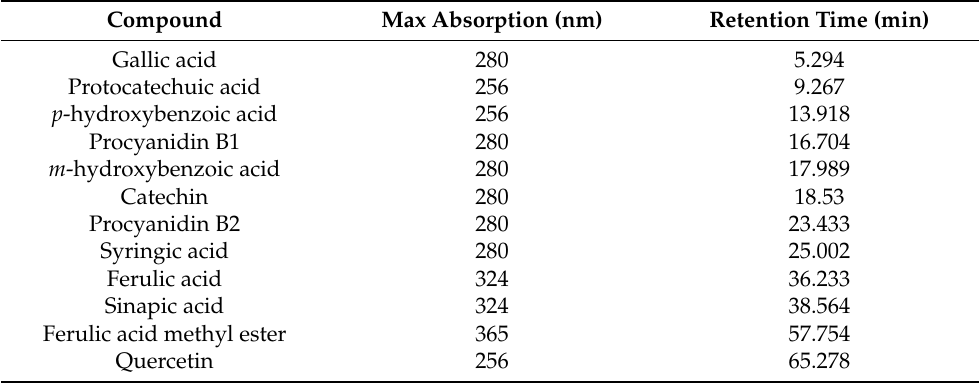
Table 4. Characteristics of polyphenol standards used in HPLC analysis and their retention times.